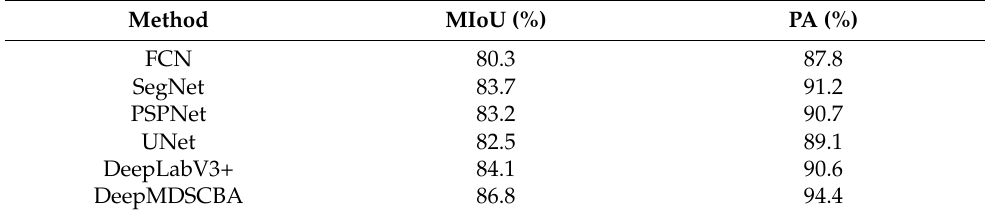
Table 11. Segmentation performance of apple images with complex